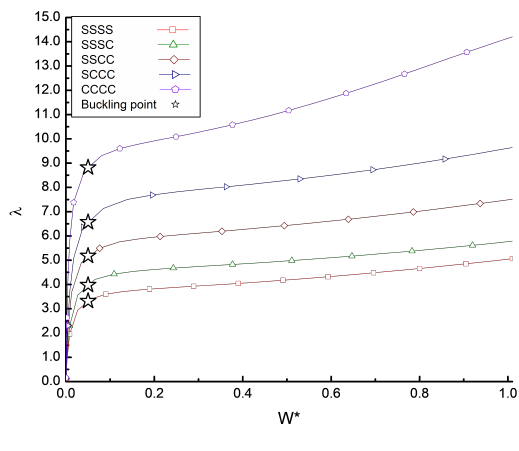
Fig. 10: Effects of boundary conditions on buckling and postbuck- ling behavior of A-type FG-ESF nanocomposite plate subjected to the uni-axial compression load.